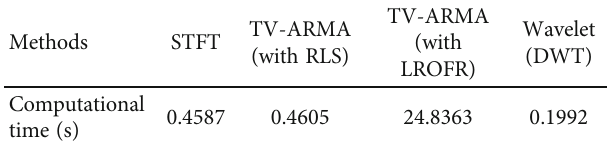
Table 6: Computational time comparison of DWT with di ff erent approaches. Methods Computational time (s)